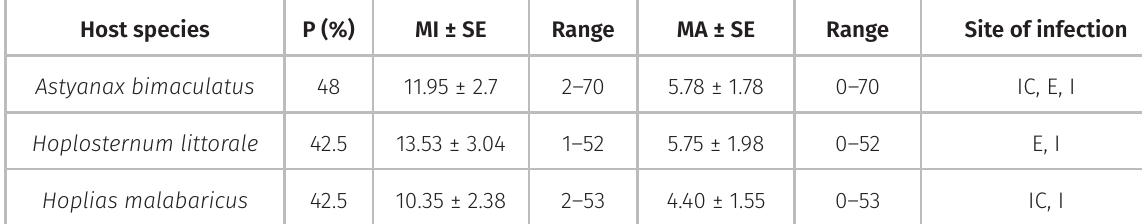
Table III. Comparative morphometry (mm) based on 10 specimens of Spiroxys sp. parasites of Astyanax bimaculatus , Hoplosternum littorale and Hoplias malabaricus (present study) and Astyanax fasciatus (Cuvier, 1819) from the upper São Francisco River, State of Minas Gerais, Brazil.